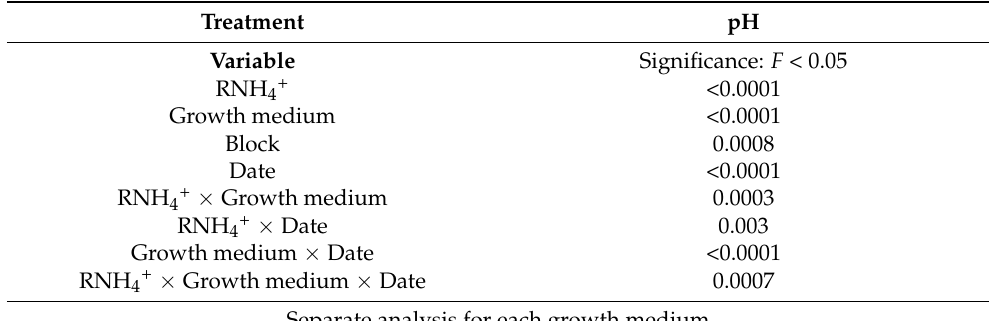
Table 2. The effects of the proportion of N-NH 4+ among the total applied inorganic N (RNH 4+